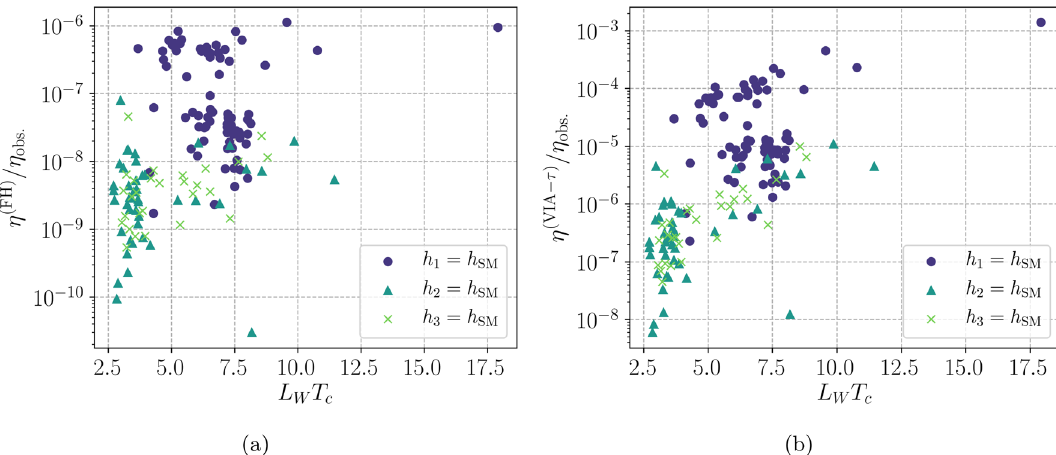
Fig. 7 BAU in the FH approach (left) and the VIA − τ approach (right) as a function of L W T c for the allowed parameter points and h 1 being the SM-like Higgs boson h SM (violet dots), h 2 being SM-like (dark-green triangles), and h 3 = h SM (green